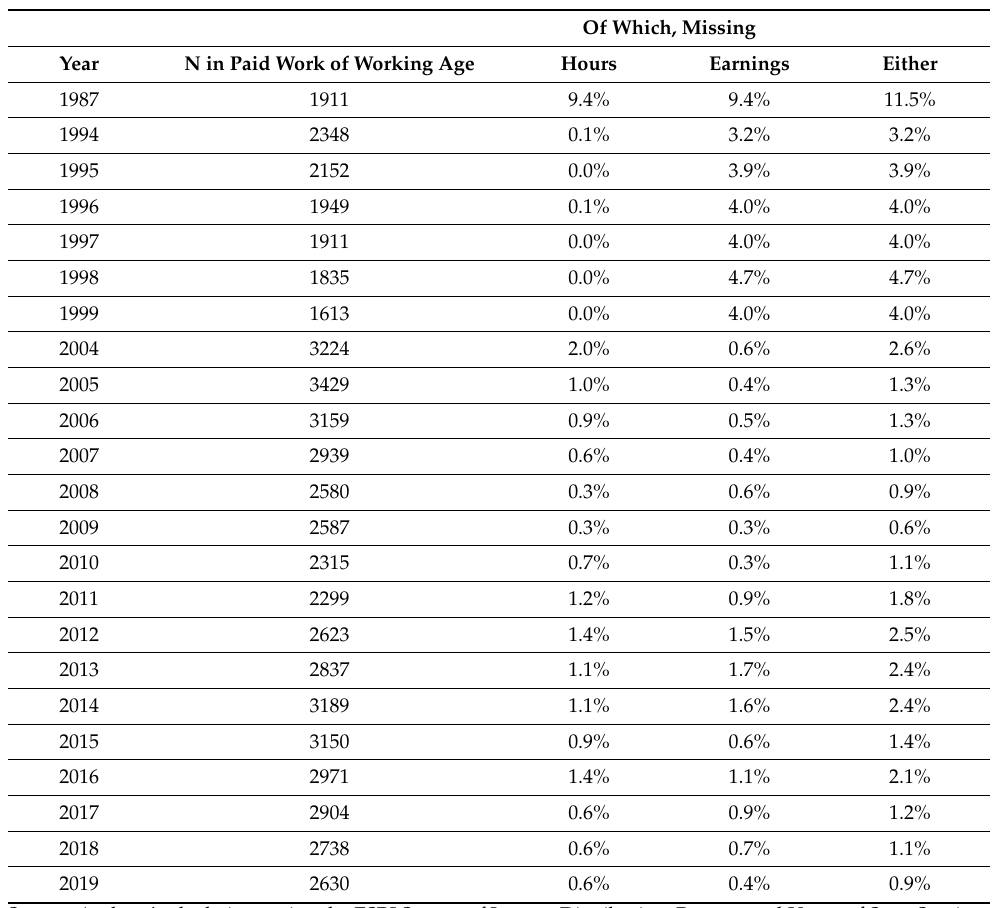
Table A1. Missing observations in hours and earnings variables by